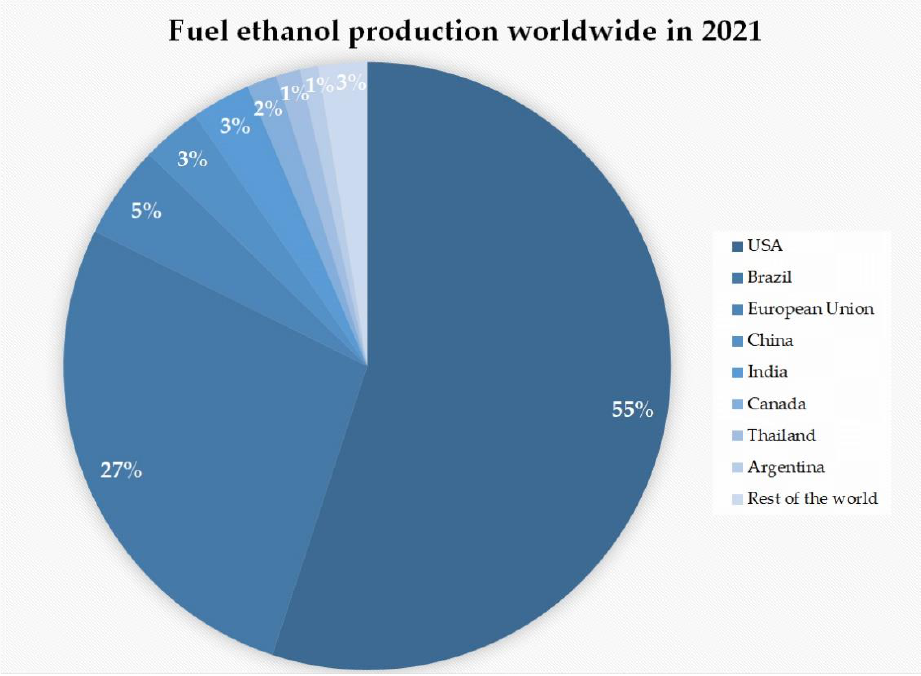
Figure 2. World’s top leaders in bioethanol production in 2021 (based on [22]). Table 1. The main fuel ethanol producers in the European Union (in millions of litres per year) [23]. Country/Calendar